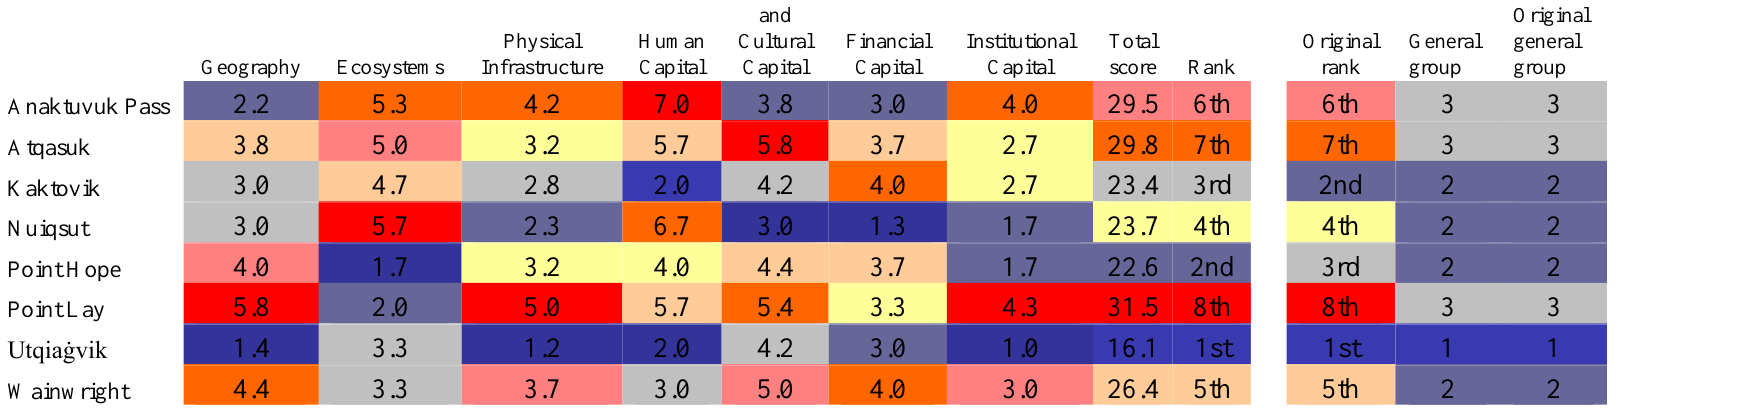
Table A3.2 Sensitivity framing, indicator